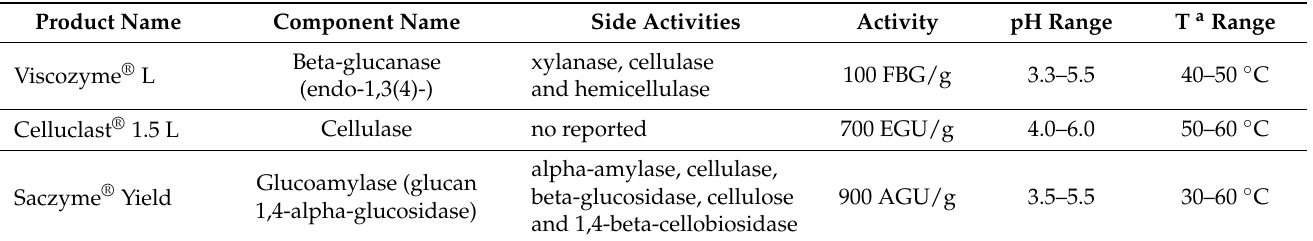
Table 2. Characteristics, components, and activities of the enzymatic solutions used a .